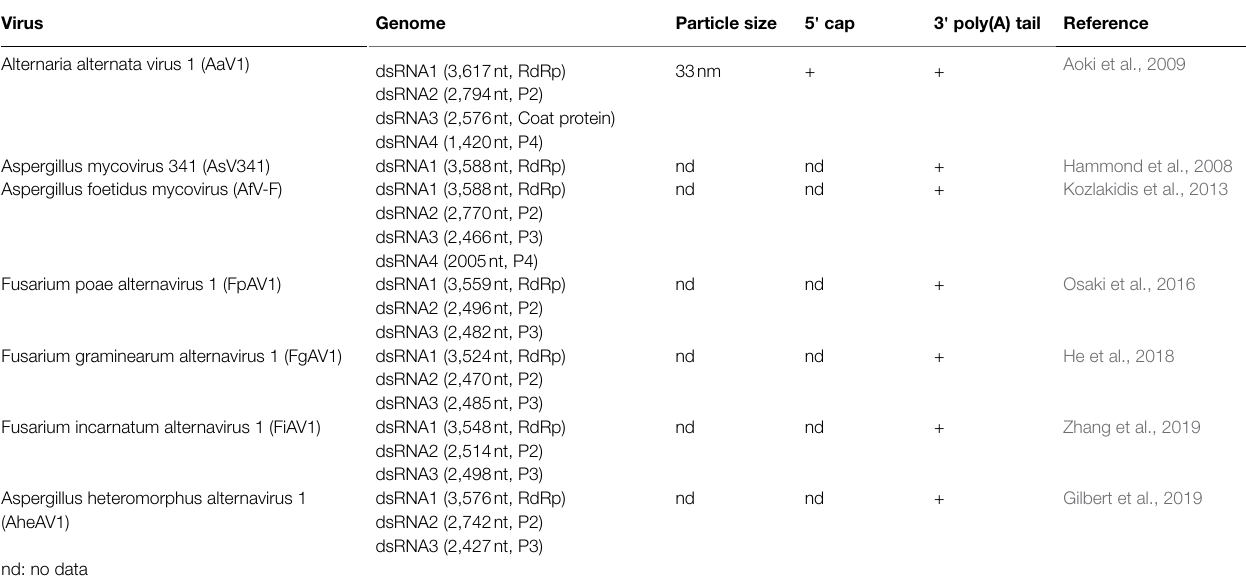
TABLE 1 | List of current members in the proposed family